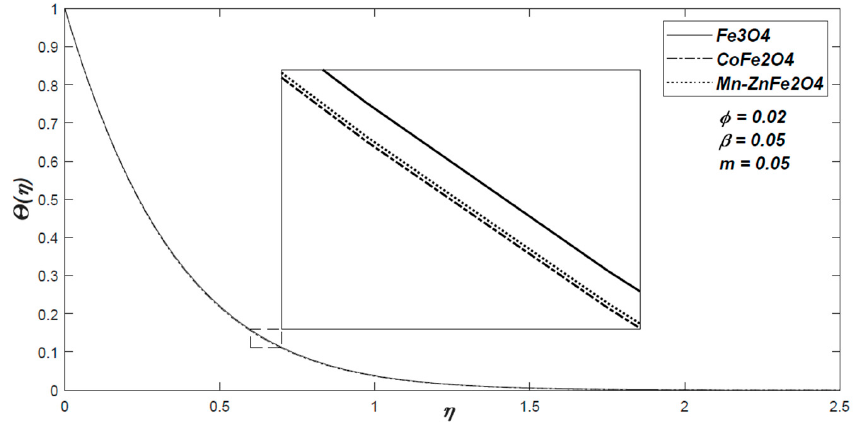
Figure 3. The variation of the nondimensional temperature for three types of nanoparticles with volume fraction φ = 0.02.